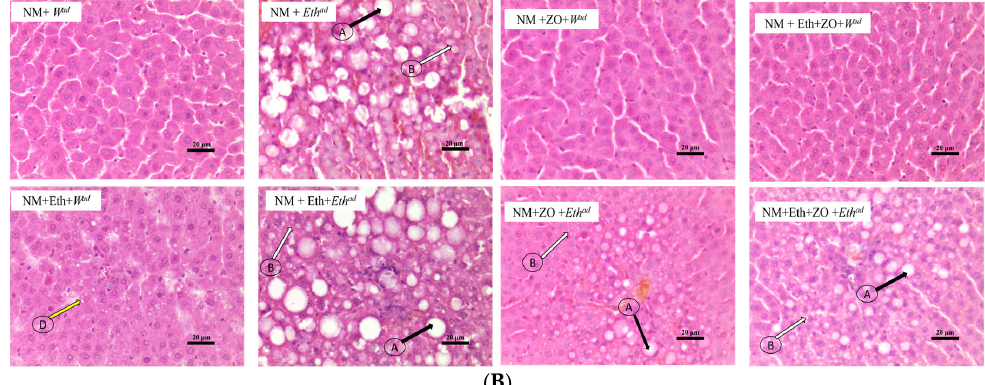
Figure 5. ( A ) Photomicrographs of male female liver sections stained with H&E. Magnification ×10 ( B ) Photomicrographs of male female liver sections stained with H&E. Magnification ×40 arrows A = large droplet macrosteatosis; arrows B = small droplet macrosteatosis; arrows C = inflammatory cell infiltrate; arrow D = microsteatosis. NM—nutritive milk; Eth—ethanol; ZO—zingerone; W—water; ad —adult treatment.